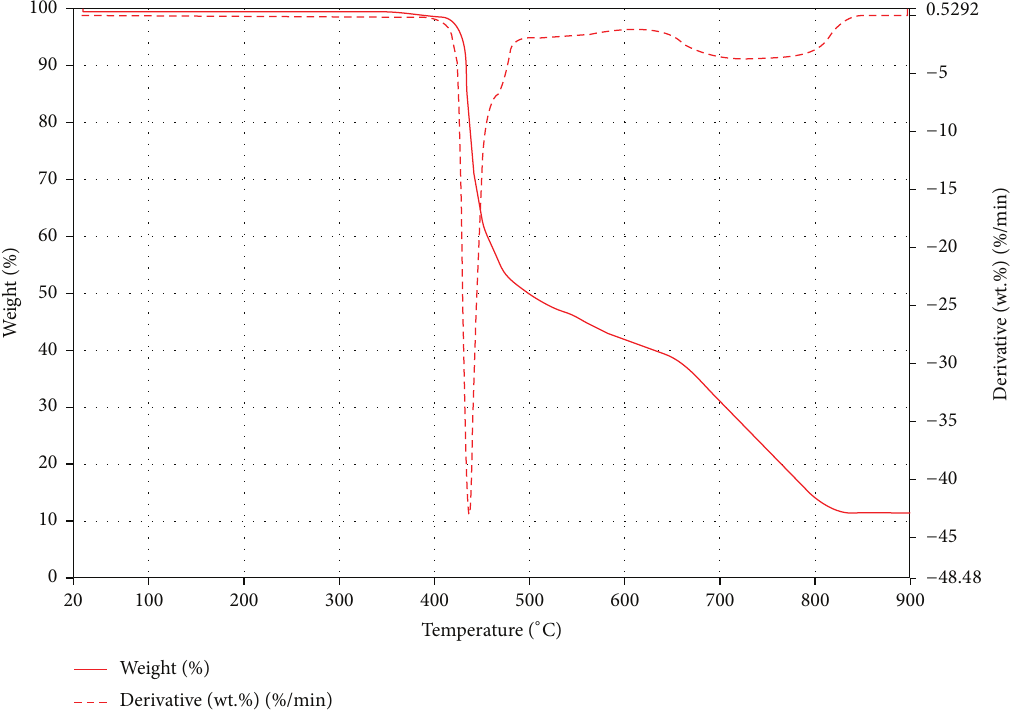
Figure 11: TGA and DTG curve of Cu(Ampp-Sn) 2 (H 2 O) 2 ⋅ H 2 O ( 1d ).